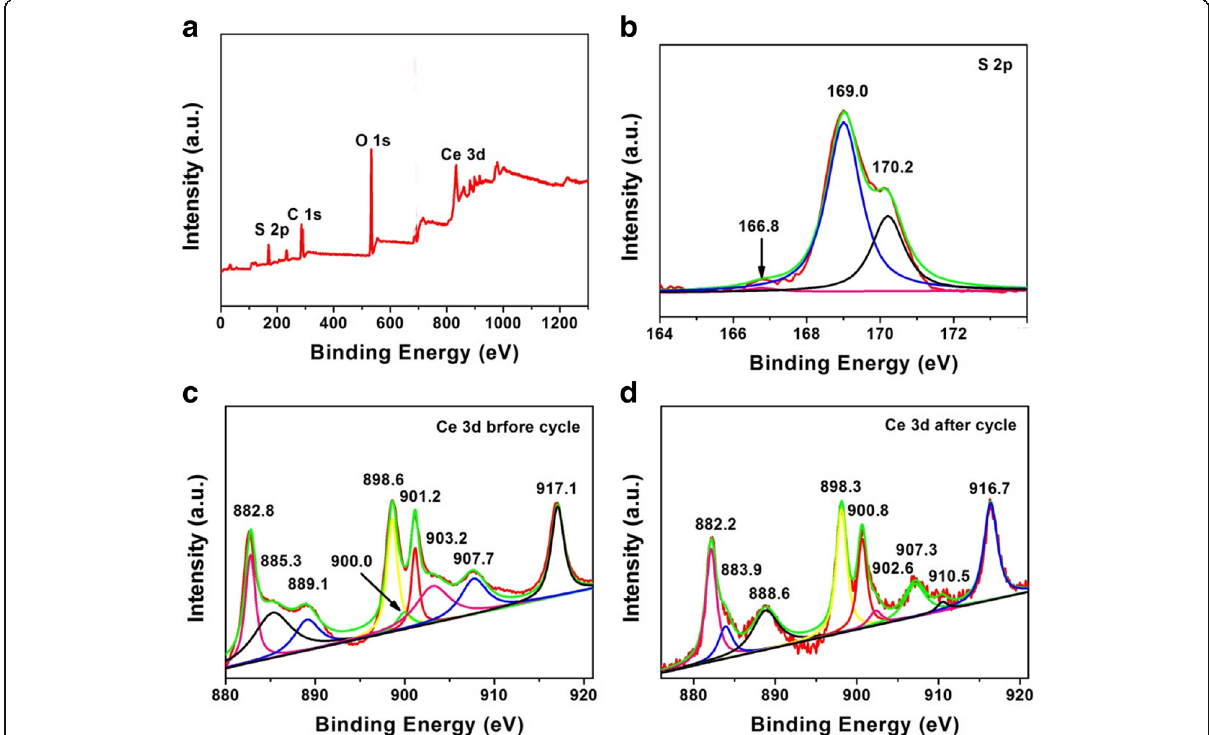
Fig. 8 XPS spectra of CeO 2 /RGO composite after cycling: survey spectrum ( a ) and S 2 p ( b ). XPS spectra of CeO 2 /RGO composite: Ce 3 d before ( c ) and after cycling ( d